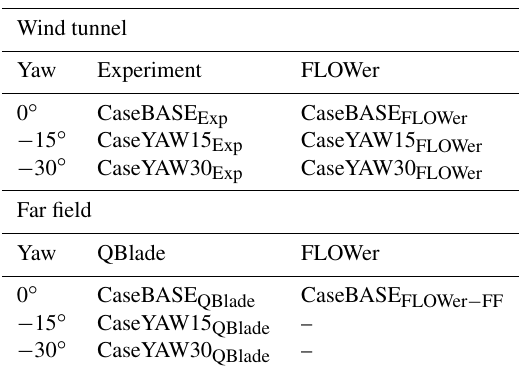
Table 1. Overview of the cases.